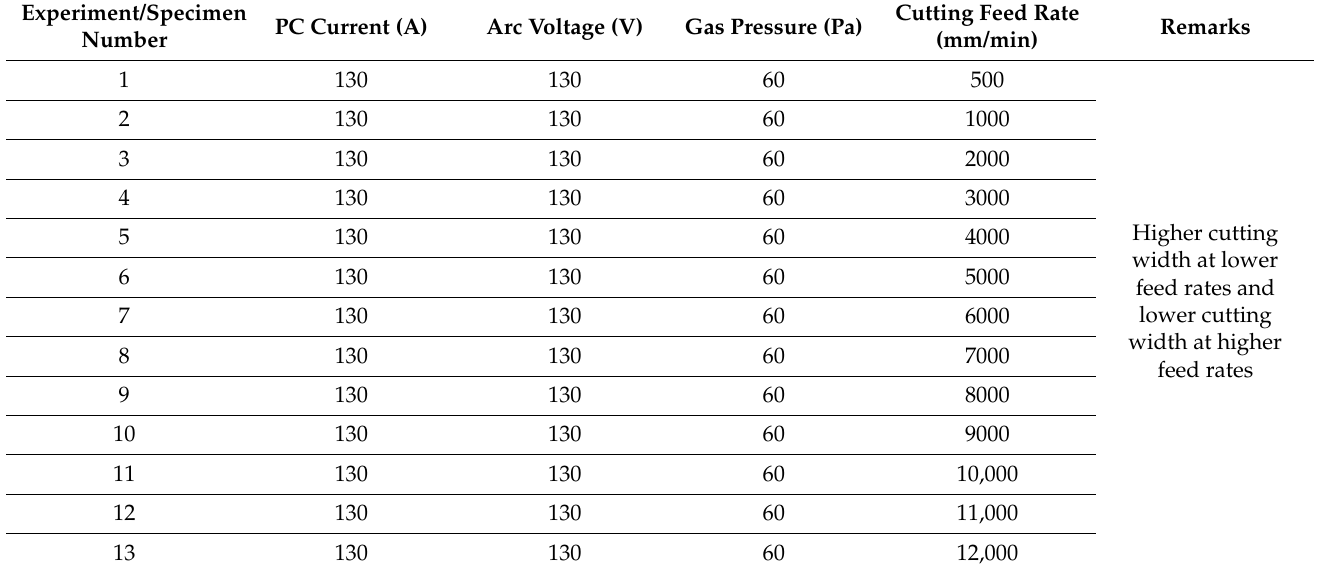
Table 2. Values used in the cutting experimental study for specimens 1 to 13 of copper for the PAC operating factors of cutting feed rates in mm/min, cutting current in amperes (A), voltage in volts (V), and gas pressure